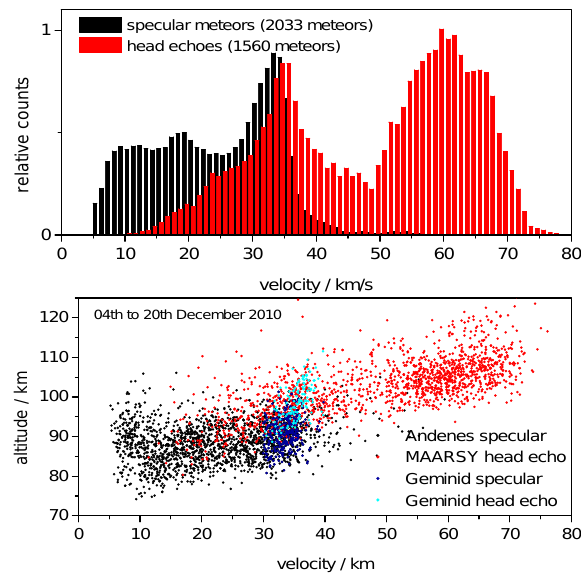
Fig. 14. Top: Meteor head echo velocity histograms for the meteor head echo and specular meteor observations. Bottom: Altitude ver- sus velocity distribution during the ECOMA sounding rocket cam-